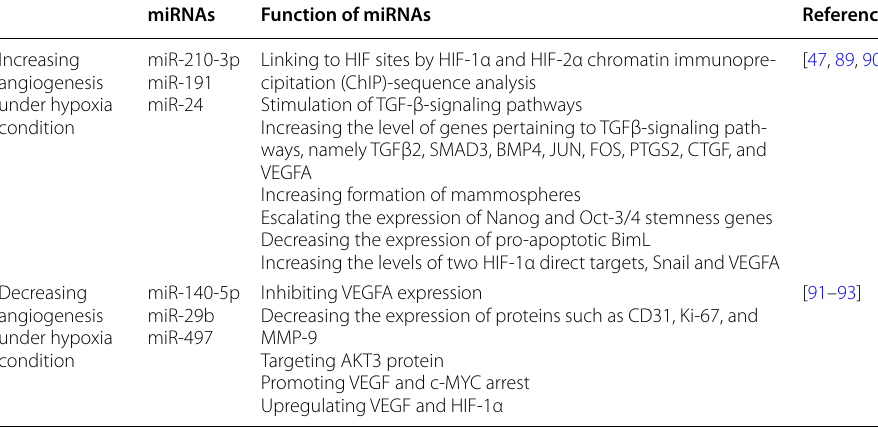
Table 3 Impact of miRNA on angiogenesis under conditions of hypoxia miRNAs Function of